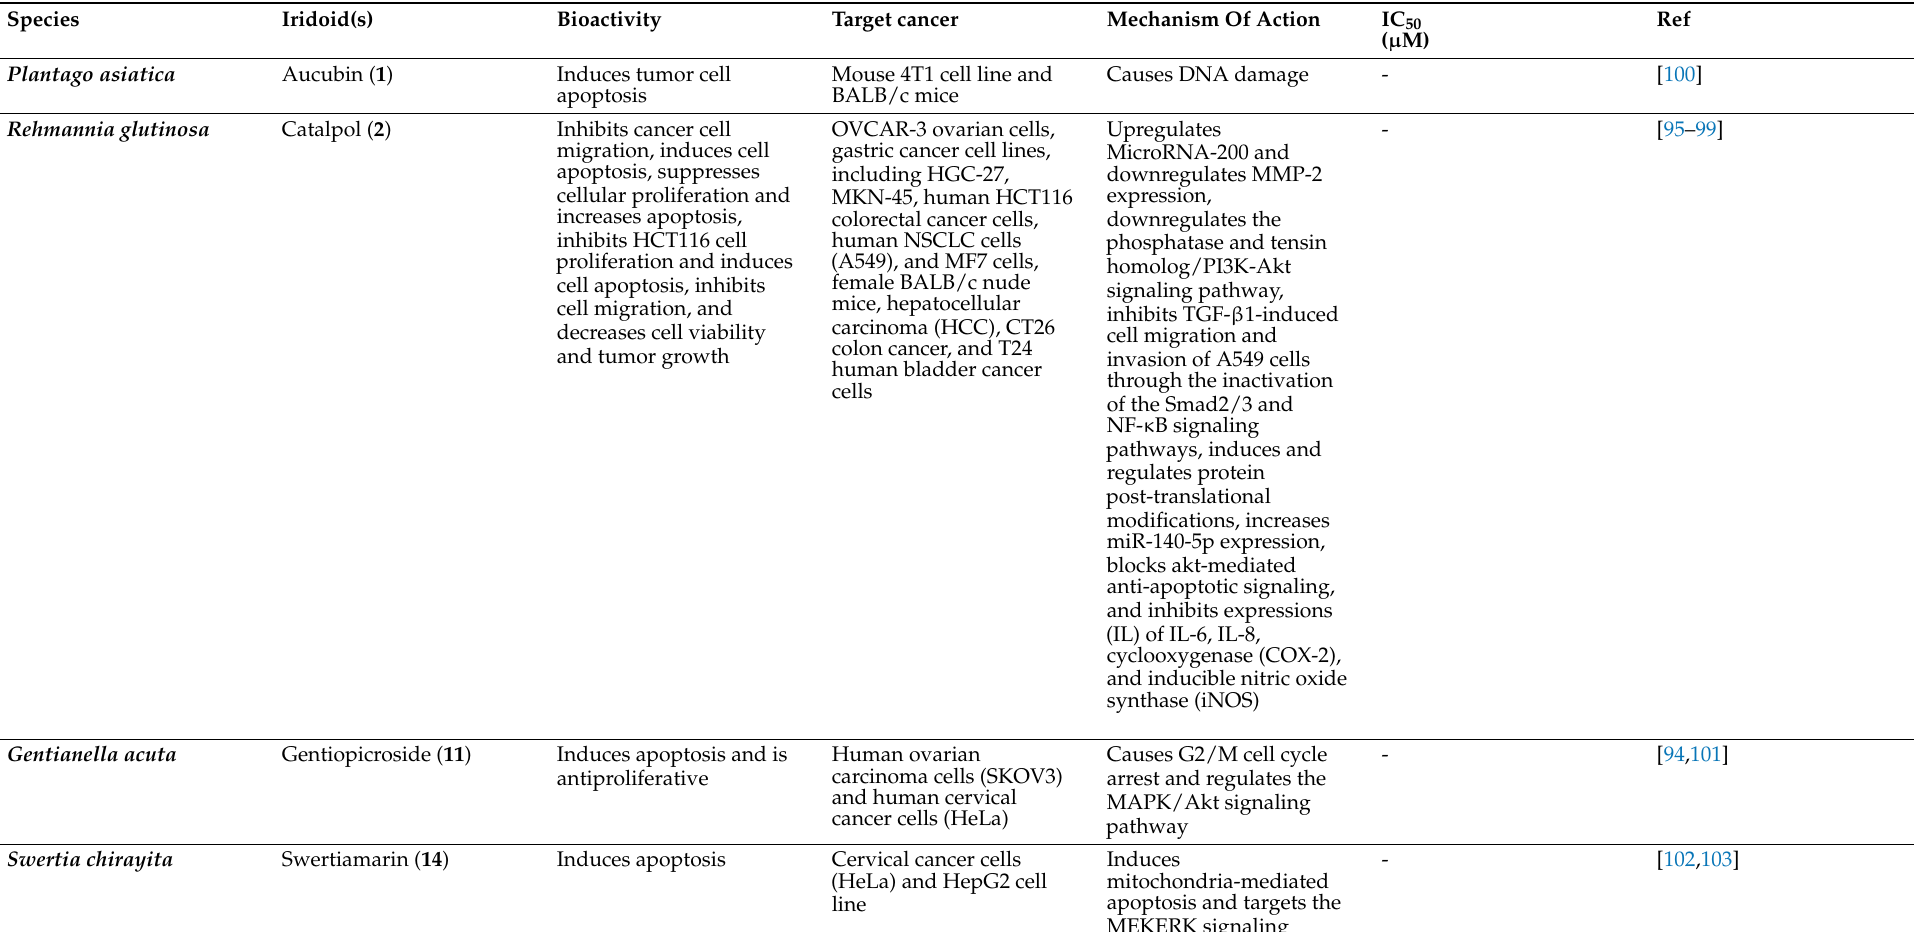
Table 1. Some of the iridoids that have been evaluated for anticancer